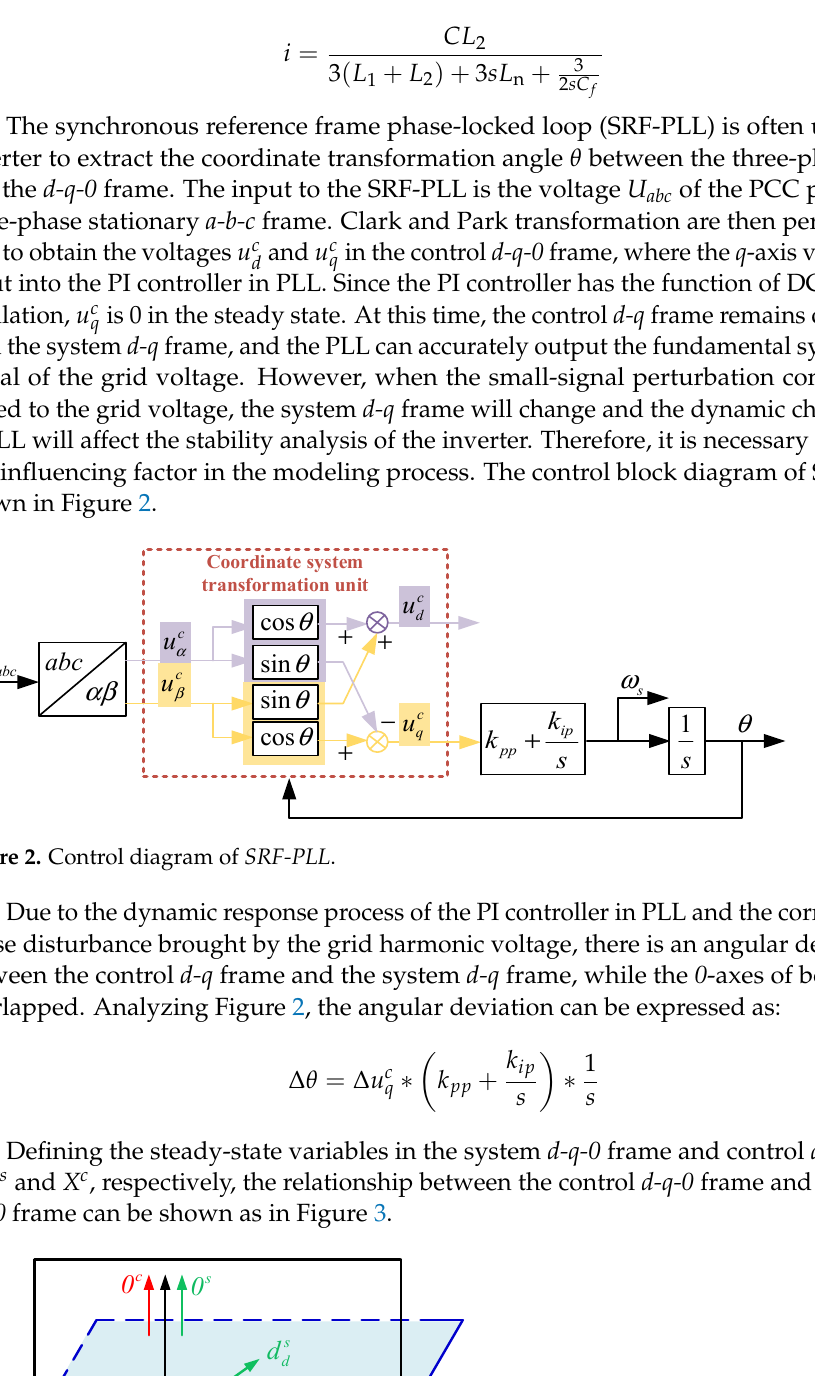
Figure 3. Relationship between the control d-q-0 frame and the system d-q-0 frame.